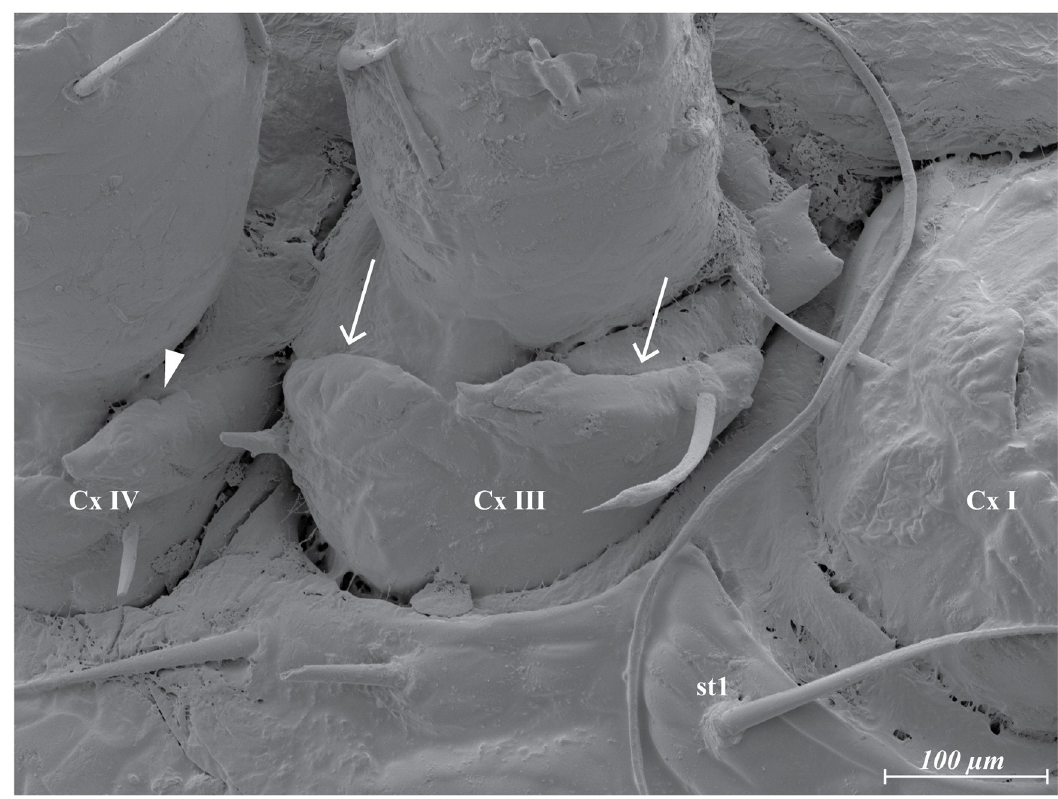
Fig 5. Megalolaelaps colossus female ventral LT-SEM image of coxae III—IV. Cx I—III, coxa I—III; st1, sternal setae 1. Possible solenostomes (arrows).